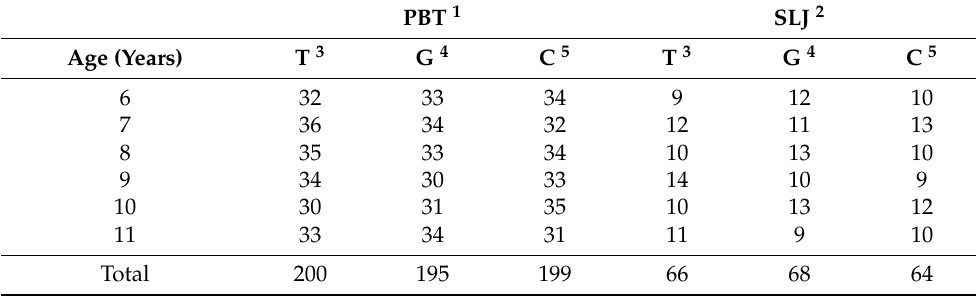
Table 2. Number of subjects per age and experimental conditions.